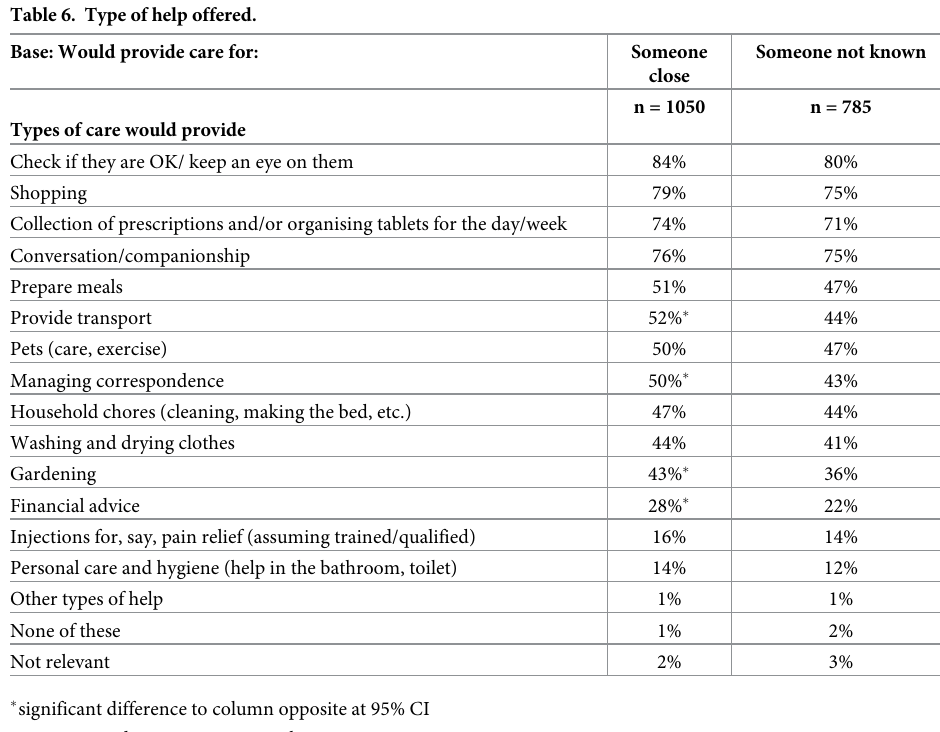
Table 6. Type of help